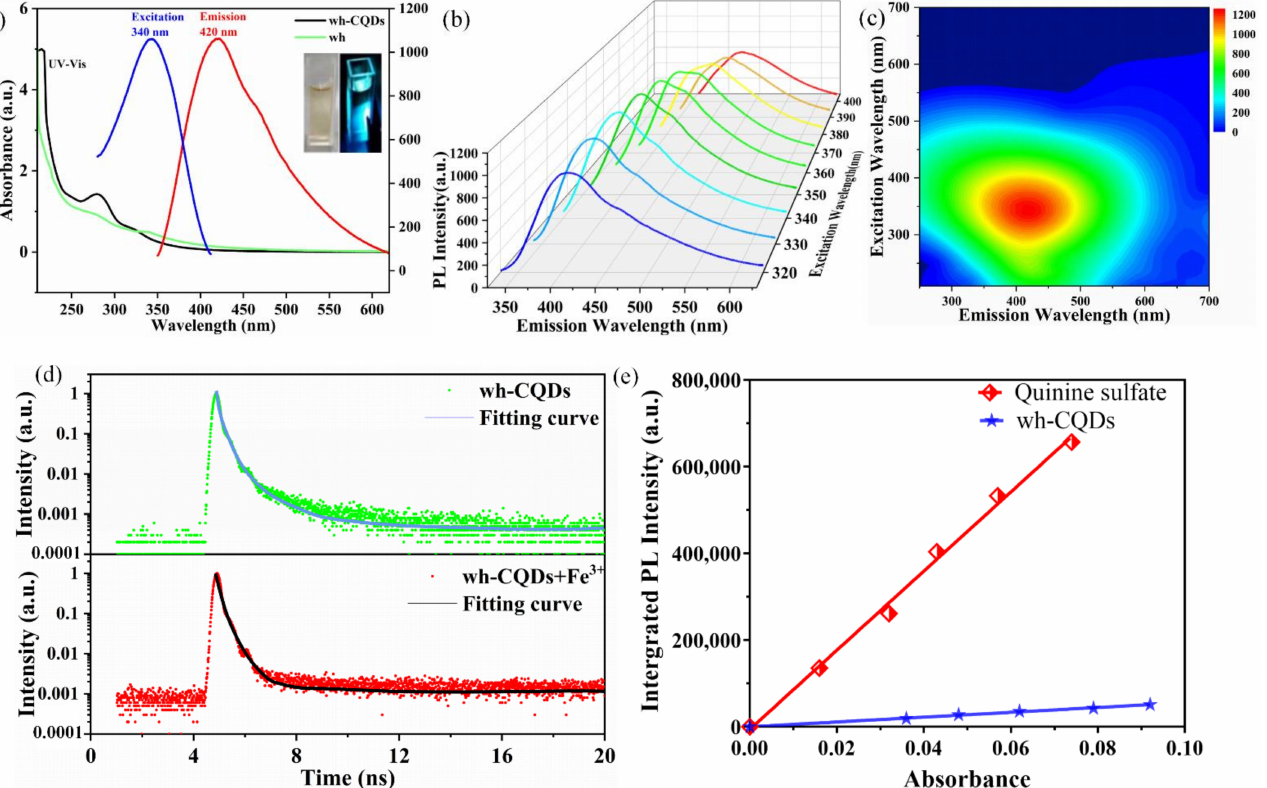
Figure 4. ( a ) UV-vis absorption with maximum fluorescence excitation and fluorescence emission spectra of the wh-CQDs, ( b ) Fluorescence emission spectra of the wh-CQDs at different excitation wavelengths ranging from 320 to 400 nm (increments of 10 nm), ( c ) 3D fluorescence contour map of the wh-CQDs, ( d ) Fluorescence decay curve of wh-CQDs before and after the addition of 100 µ M of Fe 3+ , ( e )QY measurement of wh-CQDs using quinine sulfate as the